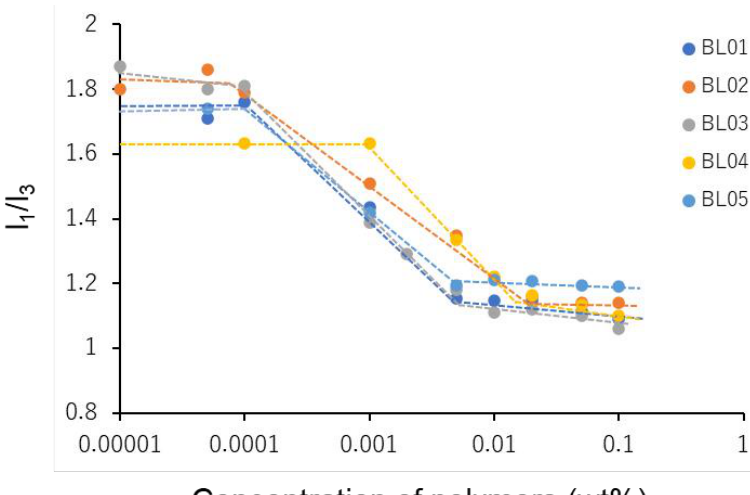
Figure 5. Plot of pyrene I1/I3 vs. concentration of polymers. A total of 0.1 mL of 1 mM pyrene in EtOH was added to 10 mL of 0.1 wt% polymer sample, and was irradiated by ultrasonic wave for 15 min.